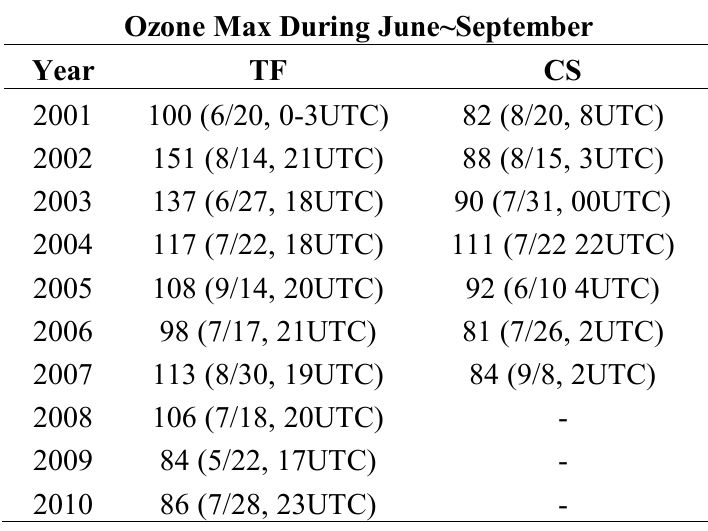
Table 1. The highest O mixing ratio in summers from 2001 to 2010 at TF and CS. Table 3 included the date and time in UTC of seasonal